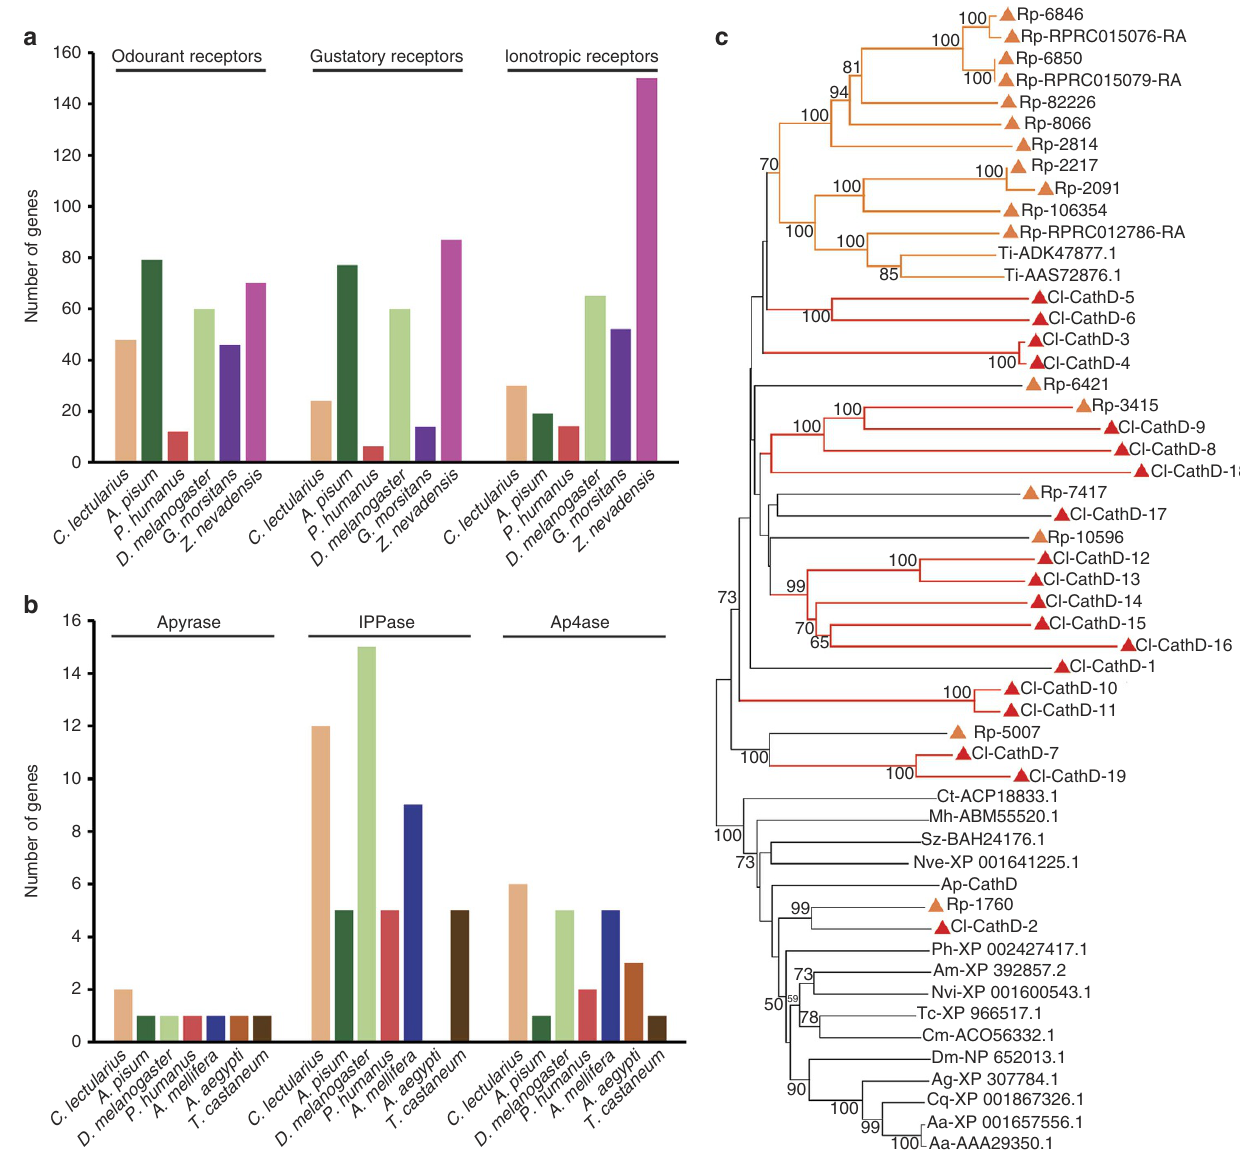
Figure 2 | Aspects related to host location and blood feeding identified based on the C . lectularius genome. ( a ) Genes associated with chemical reception among multiple insect species. Zootermopsis nevadensis ( b ) Genes associated with saliva function among multiple insect species. ( c ) Phylogeny of cathepsin D genes among multiple insect species. Sequences derived from Cimex lectularius (Cl) are denoted with red triangles and those derived from Rhodnius prolixus (Rp) are denoted with orange triangles. Other insect cathepsin D proteins represent those of Triatoma infestans (Ti), Acyrthosiphon pisum (Ap), Anopheles gambiae (Ag), Drosophila melanogaster (Dm), Pediculus humanus corporis (Ph), Apis mellifera (Am), Nasonia vitripennis (Nvi), Tribolium castaneum (Tc), Callosobruchus maculatus (Cm), Sitophilus zeamais (Sz), Chrysomela tremula (Ct), Maconellicoccus hirsutus (Mh), Nematostella vectensis (Nve), Culex quinquefasciatus (Cq) and Aedes aegypti